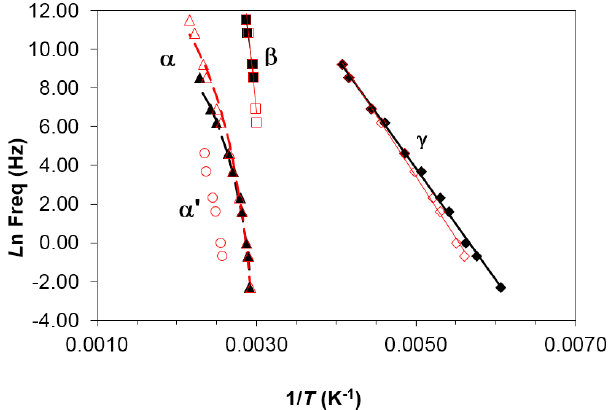
Figure 5. Relaxation map for PEI2000-PLA5 sample at different heating rates: 0.5 °C/min (open symbols) and 2 °C/min (filled symbols).